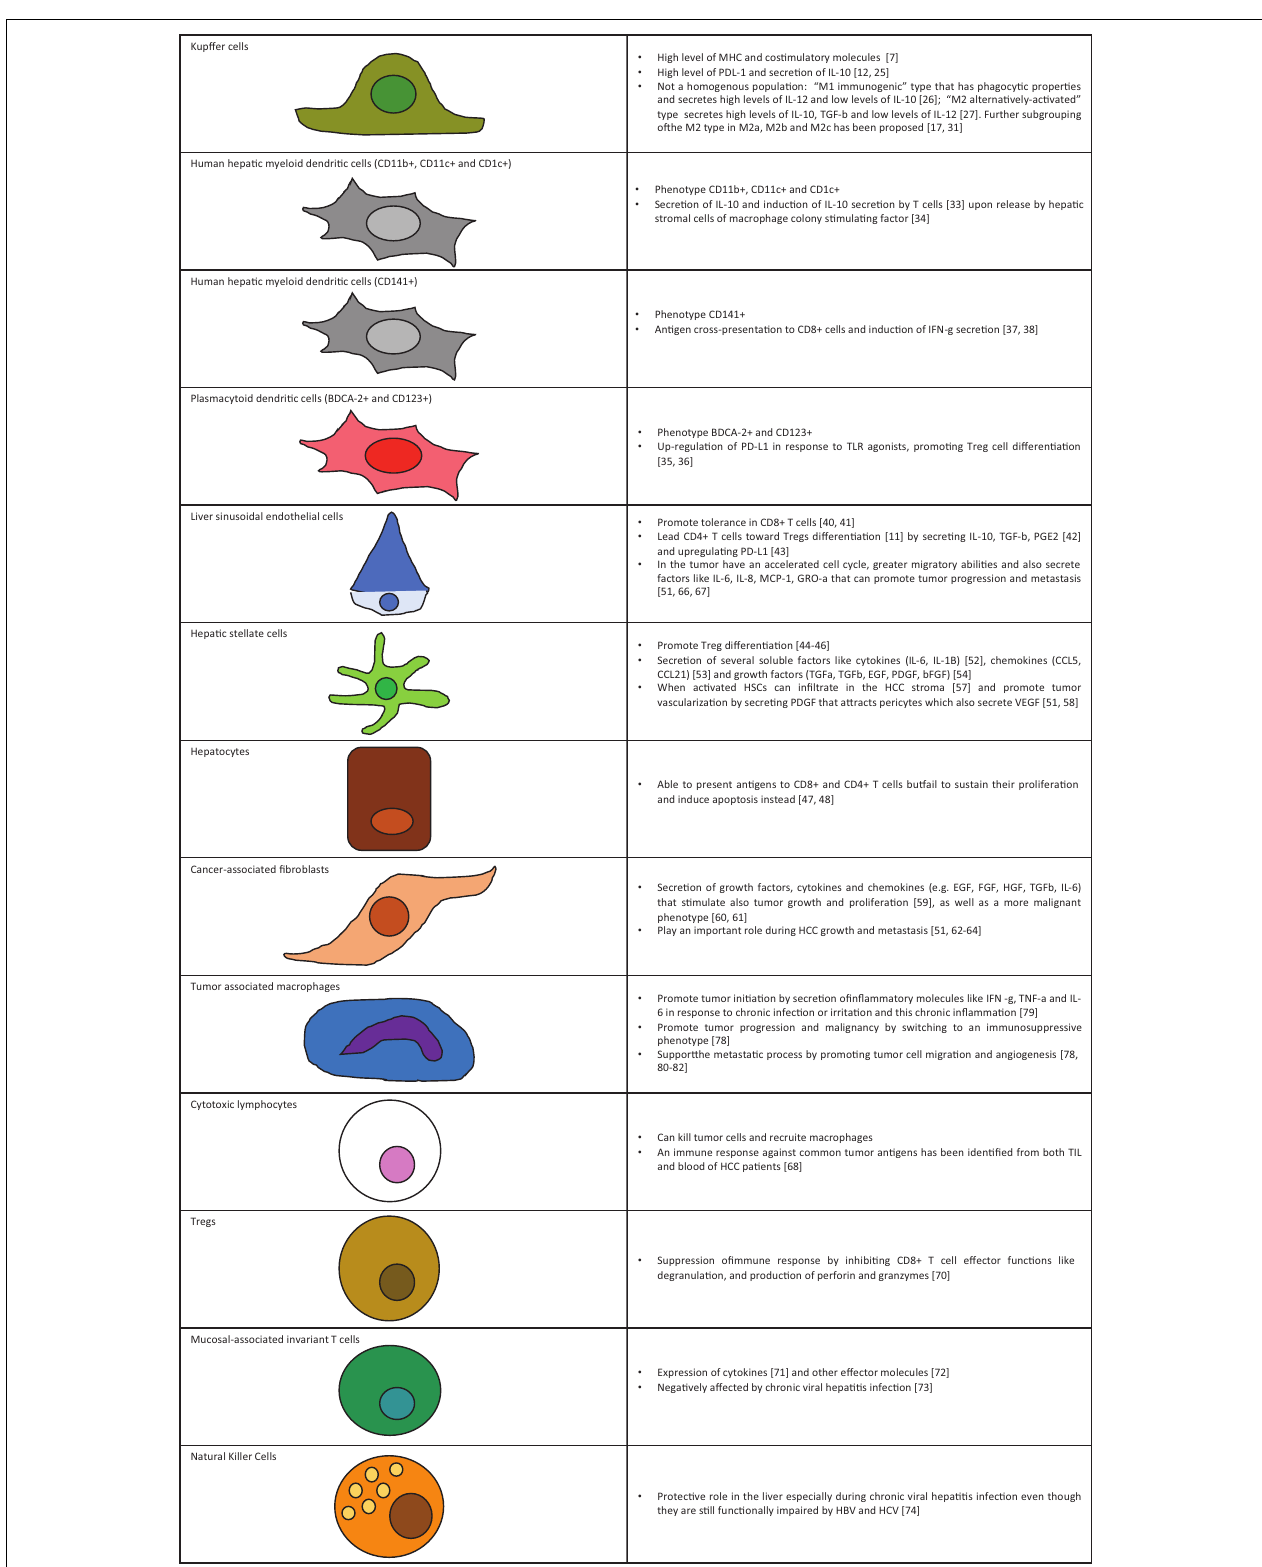
FIGURE 1 | Key cellular components of liver tumor microenvironment. Schematic representation of cell types and summary of functions in tumor microenvironment.